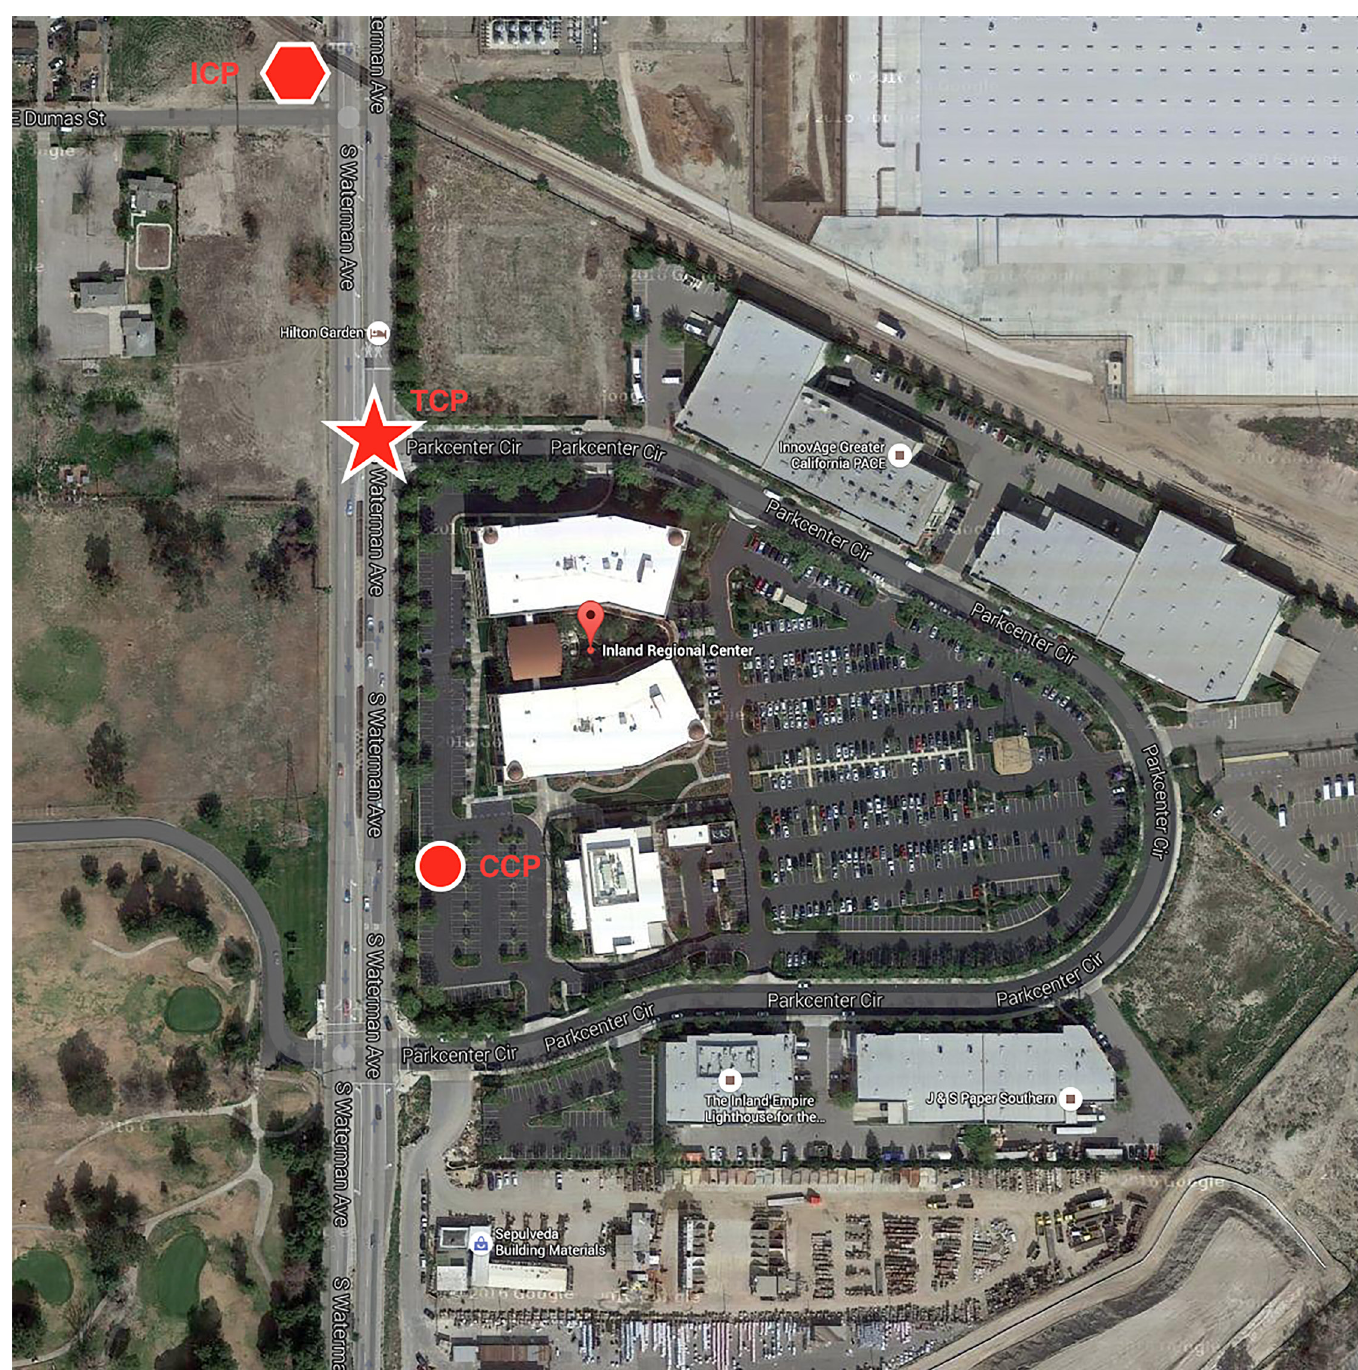
Figure 1. 3D view of IRC with tactical